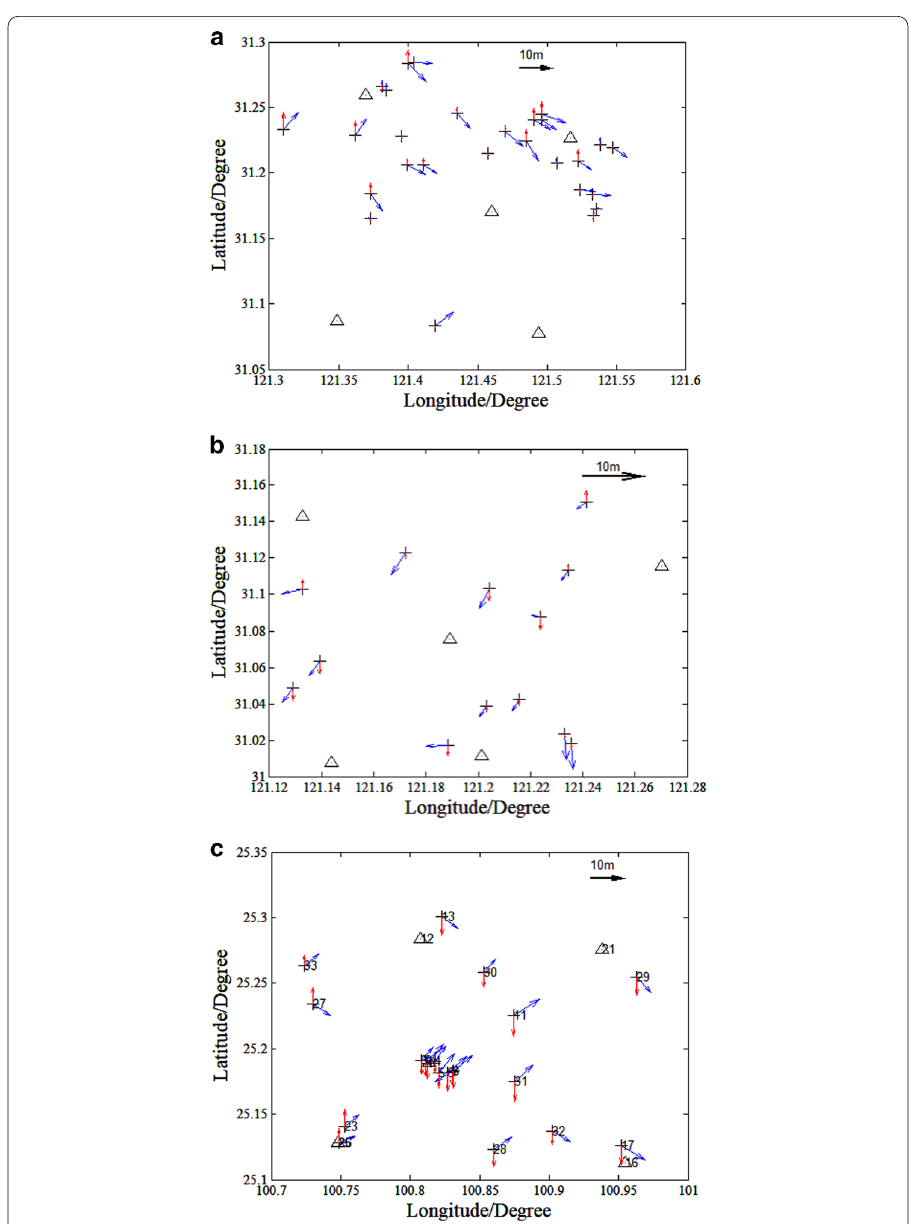
Fig. 6 Geometric positioning error bar graphs when using five GCPs. The black crosses represent the point positions in the World Geodetic System 1984, and the blue and red arrows indicate the plane and elevation errors, respectively. a – c show the results for the urban, plain, and mountainous areas,